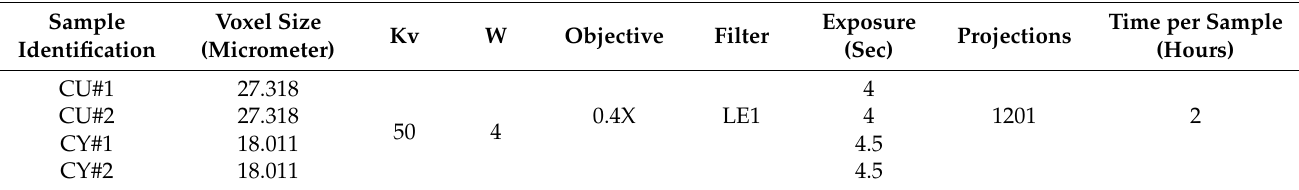
Table 1. Setting of the used Micro-CT